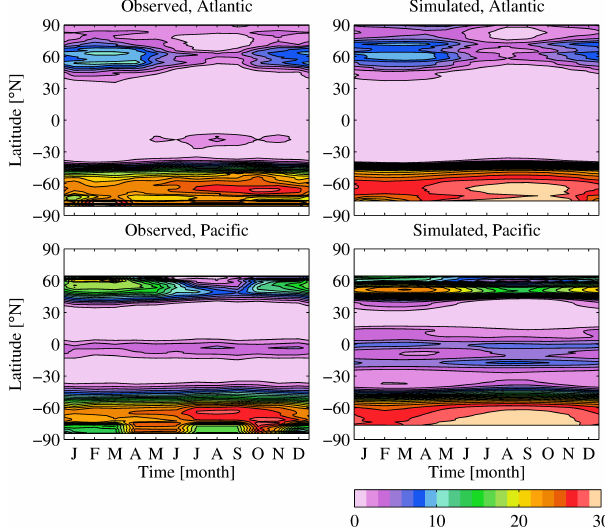
Fig. 6. Hovm¨oller diagrams of observational (World Ocean Atlas, 2009; left) and simulated (right) monthly surface dissolved inorganic nitrogen, averaged zonally for the Atlantic (top) and Pacific (bottom) basins. Concentrations in mmolNm − 3 .